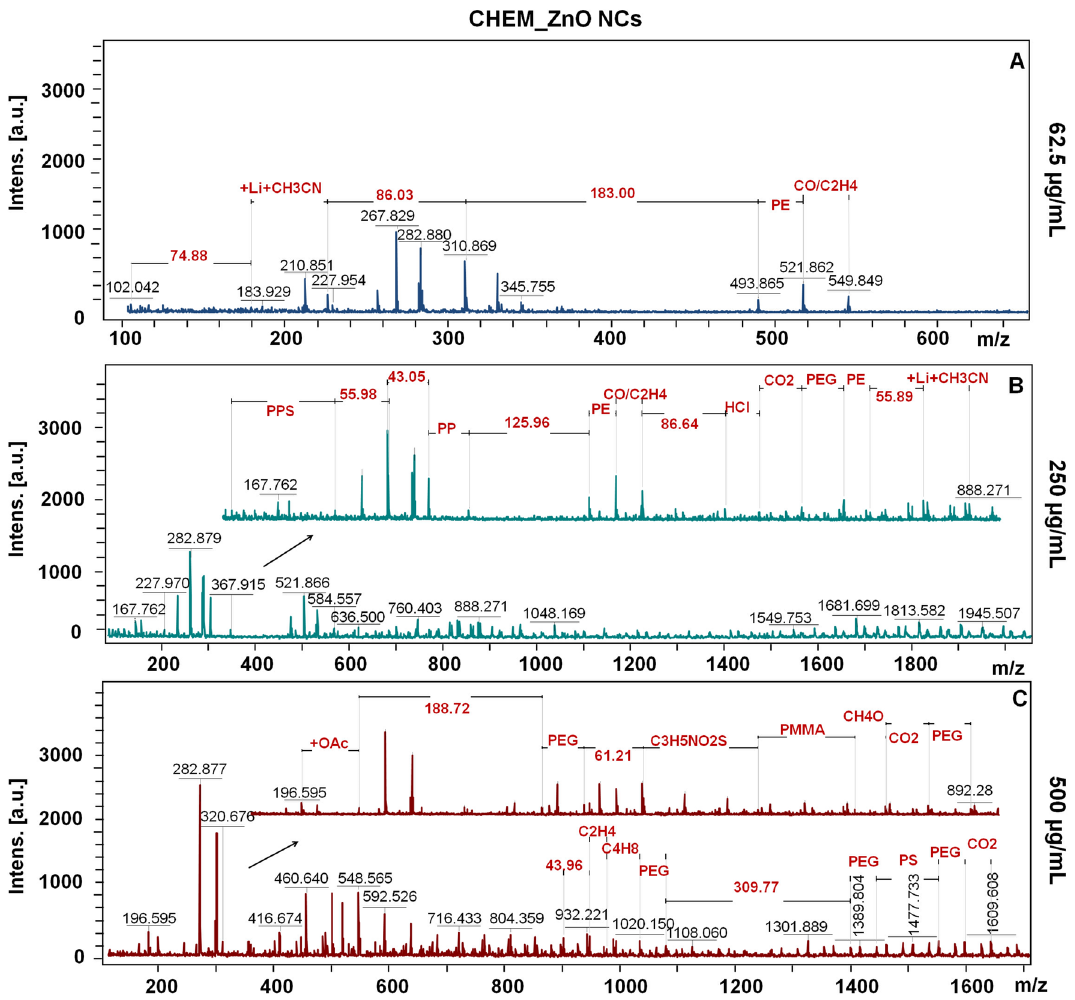
Figure 5. The LDI-TOF-MS spectra for core–shell signals of CHEM_ZnO NCs at 62.6 ( A ), 250 ( B ) and 500 ( C ) µg/mL